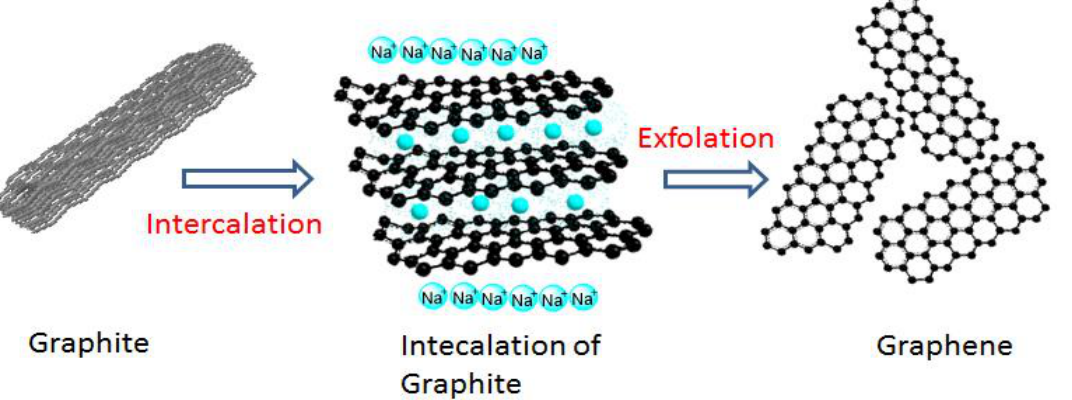
Figure 1. Schematic showing intercalation of solvated Na ions between graphite layers leading to the formation of individual graphene sheets.